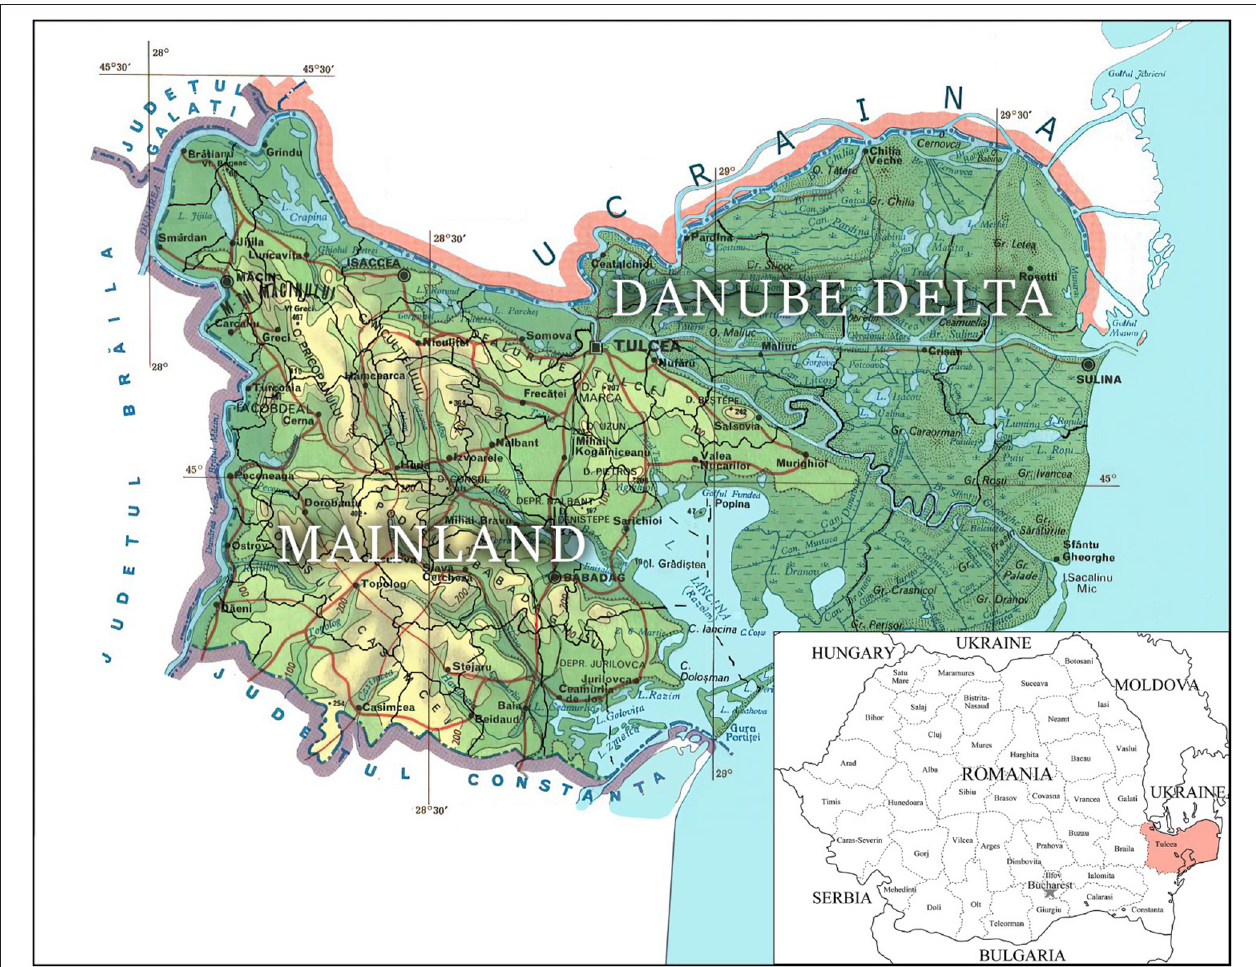
FIGURE 1 | Tulcea County, total area 849.875 ha, with 363.941 ha of agricultural land, 103.545 ha of forests and forest vegetation, 342.132 ha covered with water and ponds, 294.039 ha registered as arable, and 60.597 ha natural pastures 3,4 .